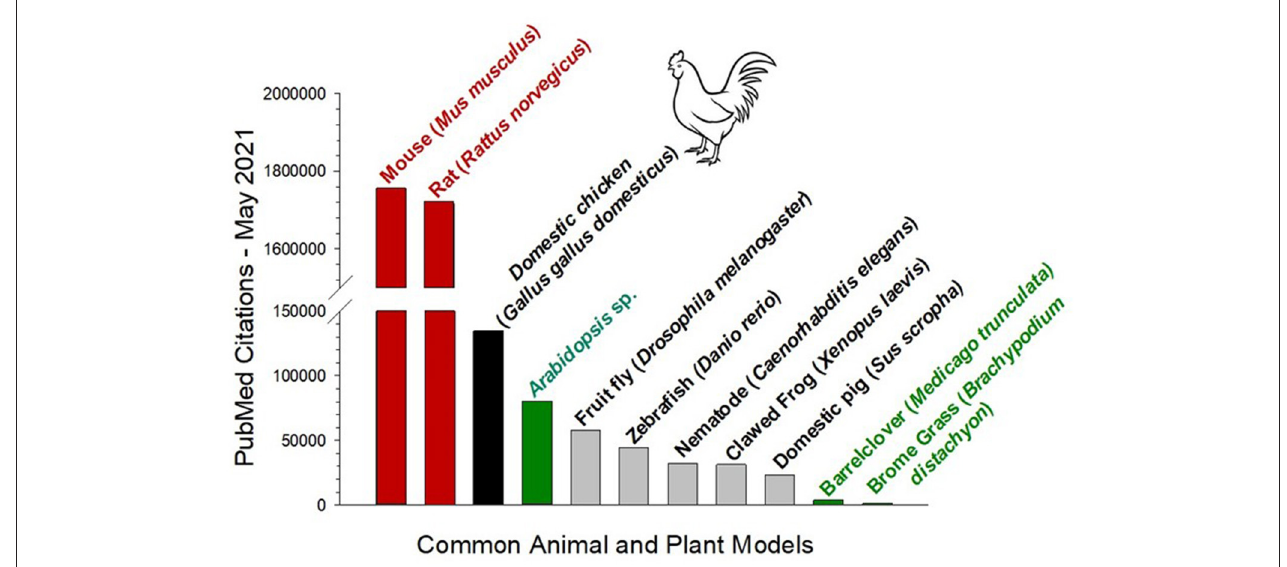
FIGURE 1 | Total number of PubMed citations of common animal and plant models derived from the Latin genus and species. Data acquired May, 2021. The two common rodent models (red) are highly dominant in biomedical research. However, while the zebrafish D. rerio and the nematode C. elegans are receiving much attention, both have less than a third of the PubMed citations as the domestic chicken (black). Also shown for comparison are three commonly used plant models